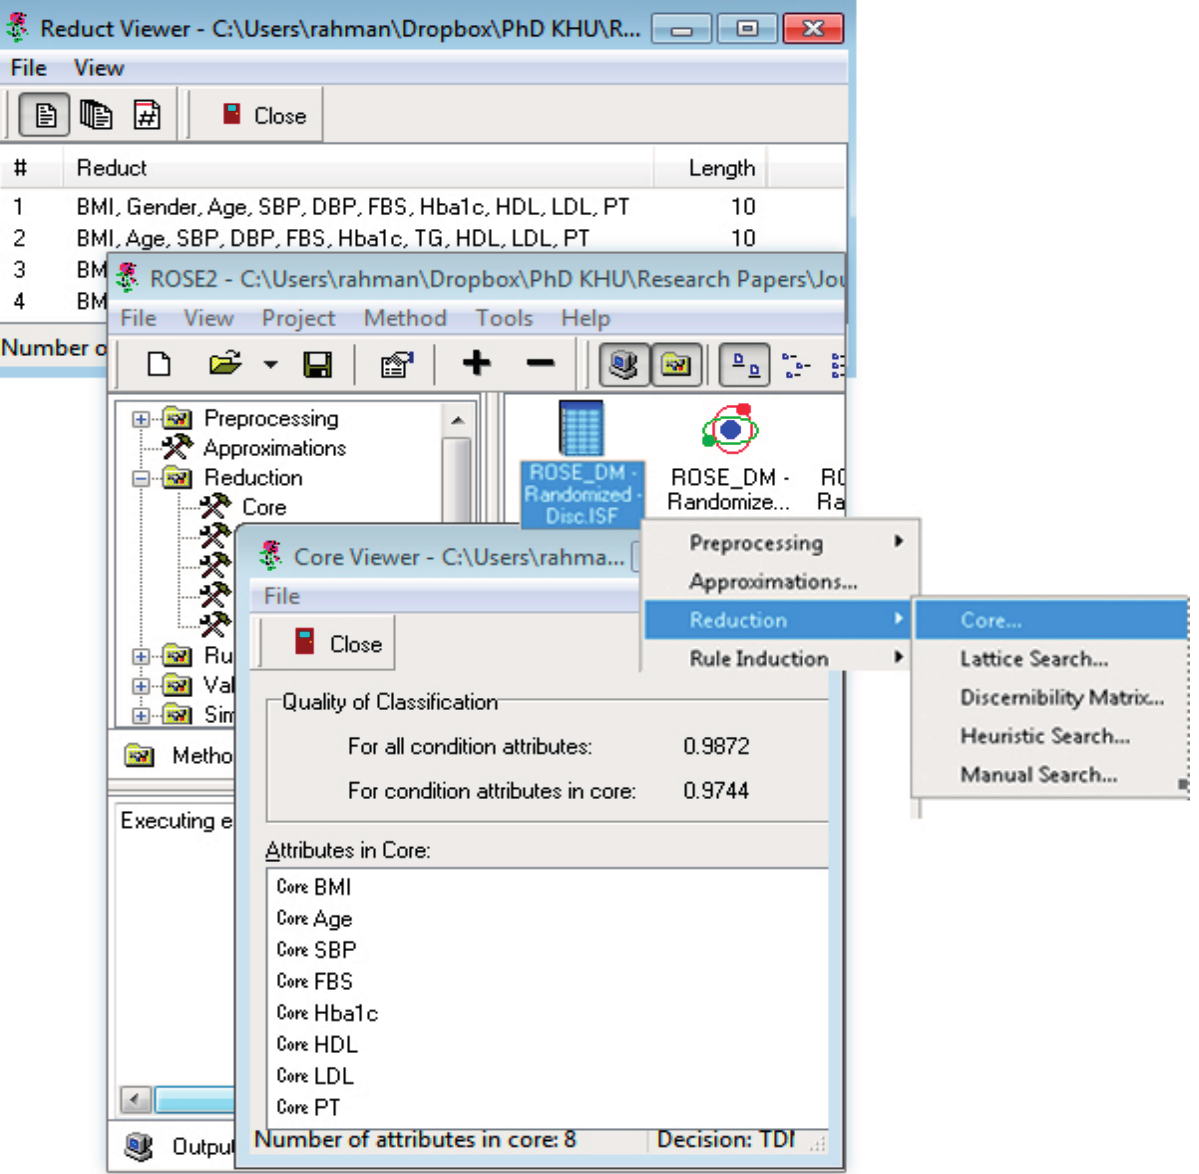
Figure A2. Reducts and core generation process in rough set data exploration system (ROSE 2) system along with the